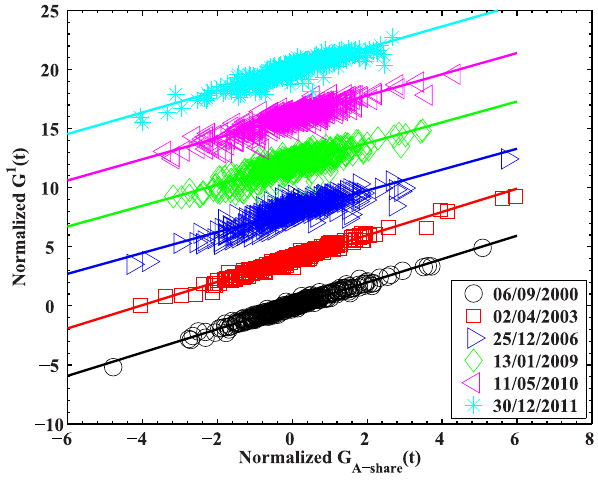
Figure 10. Projection G 1 ( t ) of the 367 stock returns on the largest eigenvector u 1 . G 1 ( t ) obtained from the correlation matrices of the return series in the moving windows ended on 06/09/2000, 02/ 04/2003, 25/12/2006, 13/01/2009, 11/05/2010, and 30/12/2011, as a function of the return of the A-share Index of Shanghai Stock Exchange. The A-share Index is composed of all the A-share stocks listed on the Shanghai Stock Exchange. Curves are removed for clarity. A linear regression between the two normalized axes for different moving windows yields slopes: 0.99, 0.99, 0.88, 0.88, 0.90, and 0.91.